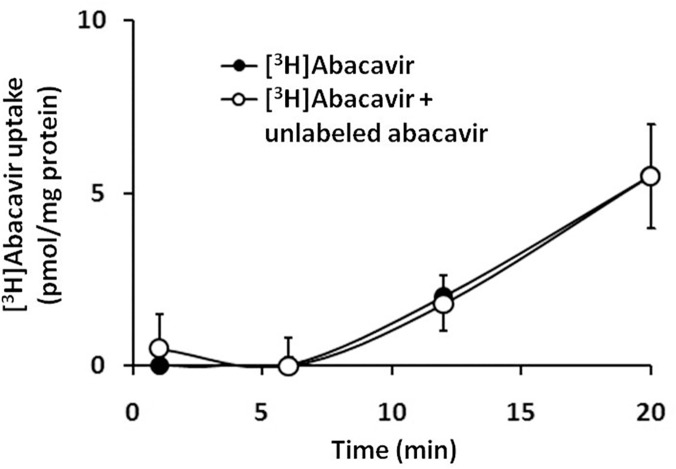
Uptake of [3H]abacavir by HUVECs.Uptake of [3H]abacavir (2 μCi/mL, 1 nM) by HUVECs was measured after incubation with [3H]abacavir with or without unlabeled abacavir (20 μM) for 1, 6, 12, and 20 min at room temperature. Values are means ± S.E.M. of three sets of experiments carried out in triplicate and statistical comparisons were made using ANOVA.